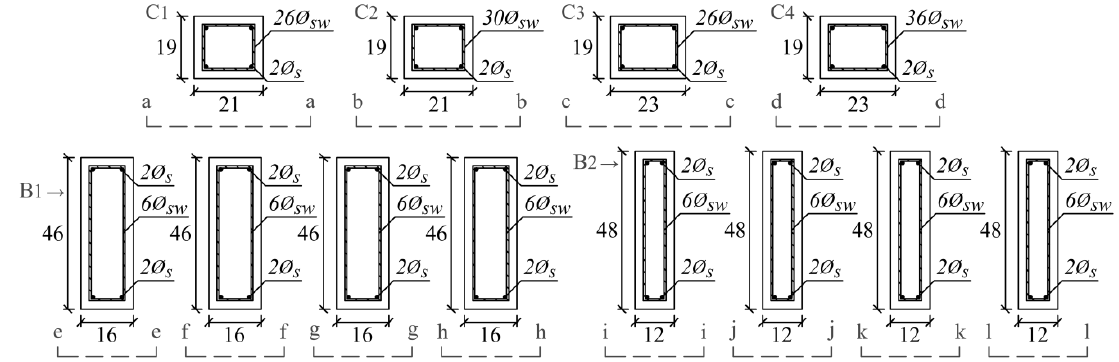
Figure 8. Detailing the optimal sections (dimensions in cm) - Example I: case